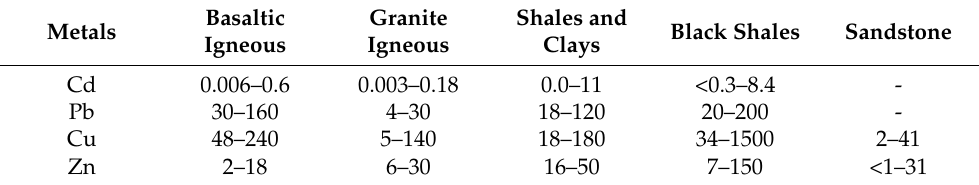
Table 1. Range of heavy metal concentrations (ppm) in igneous and sedimentary rocks (Modified from Cannon et al.